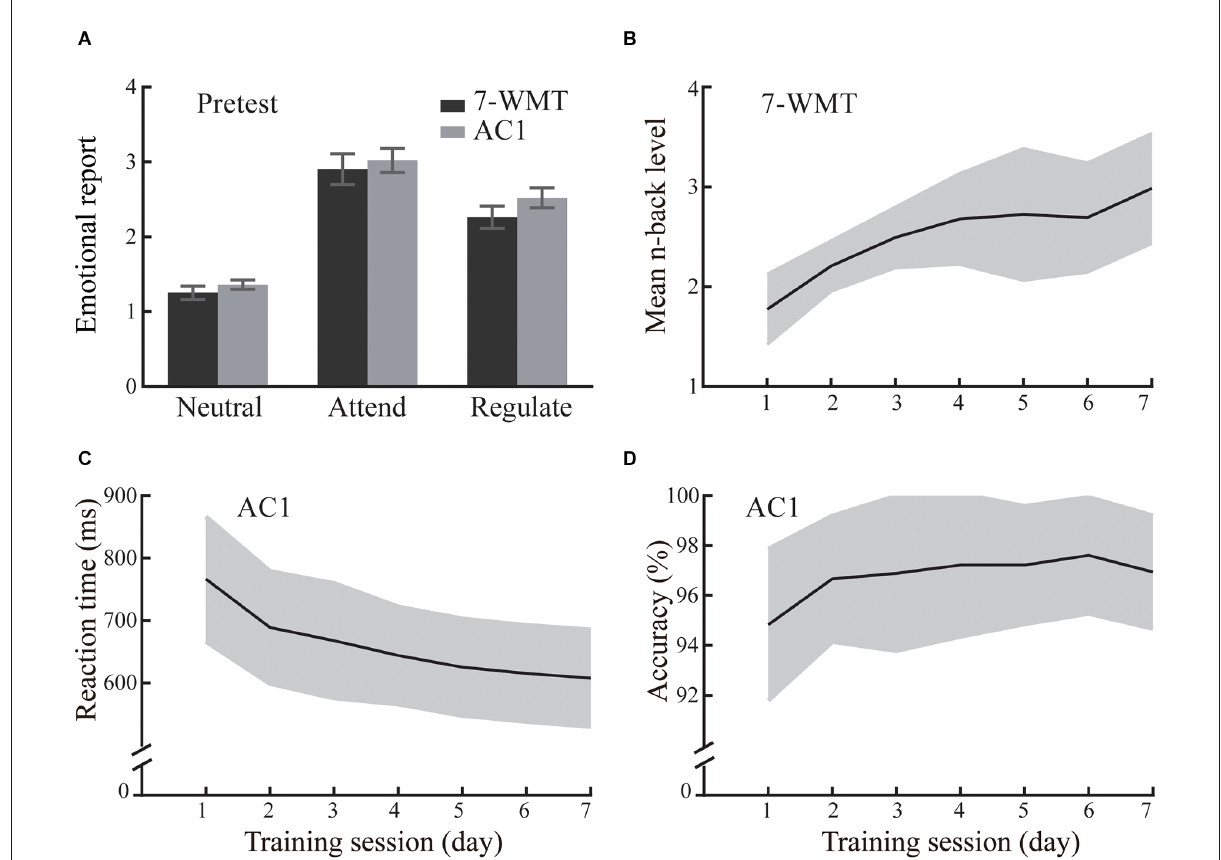
FIGURE2 The emotional reports and training performance of the 7-day WM training group (7-WMT) and active control group (AC1) in Experiment 1. The 7-WMT and the AC1 group experienced similar emotions at the pretest (A) . Error bars represent standard errors. The improved performance in the trained task is shown separately for the 7-WMT group (B) and the AC1 group (C,D) . The shading around the solid line indicates the standard deviation.